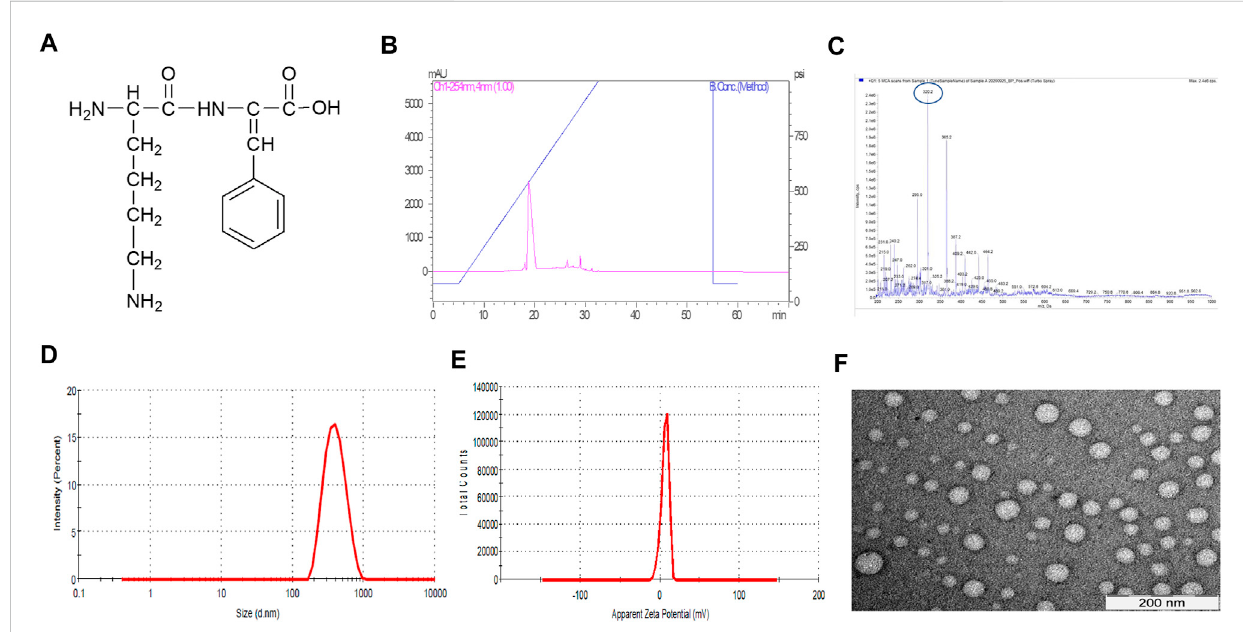
FIGURE 1 (A) Chemical structure of R Δ F. (B) RP-HPLC pro fi le of R Δ F. (C) Mass spectrometry (electron spray ionization) pro fi le of R Δ F. (D) Hydrodynamic diameter ofself-assembled R Δ Fat1 mg/mLconcentrationshowstheformationofhomogeneousNPs( n =5). (E) ZetapotentialofR Δ FNPsusingDLS. (F) Transmission electron microscopy image of R Δ F